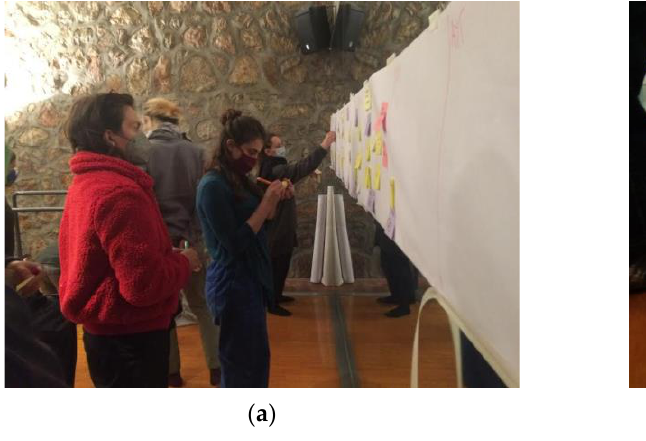
Figure 3. Dancers and choreographers that responded to the open call co-produce the calendar of events ( a ) working together in search of complementarities between their proposals ( b ). Event organized by dancer and choreographer Vitoria Kotsialou and Mariela Nestora (Photo credit: Monica Vaxevani).